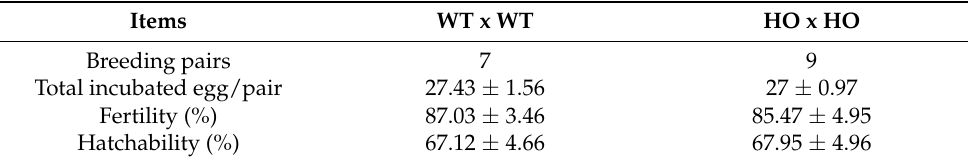
Table 2. Comparisons of fertility and hatchability of eggs from WT and HO breeding